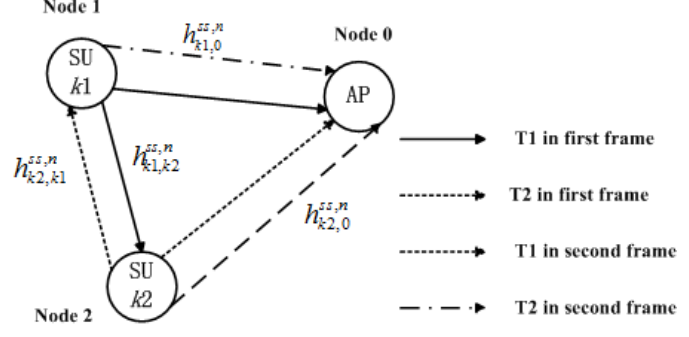
Figure 2. Model for cooperative transmission.